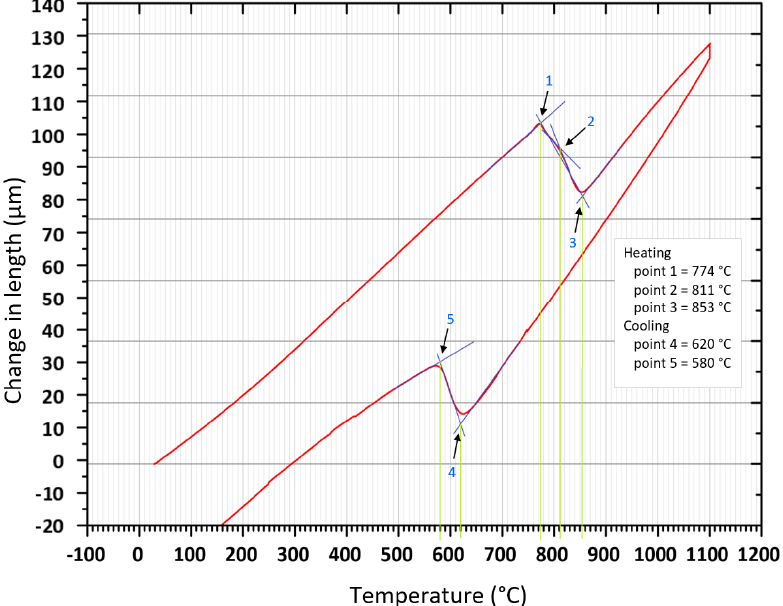
Figure 4. Dilatometry curves for 10 °C/s heating rate and 1 °C/s cooling rate (variant H10 C1) with three tangents applied.